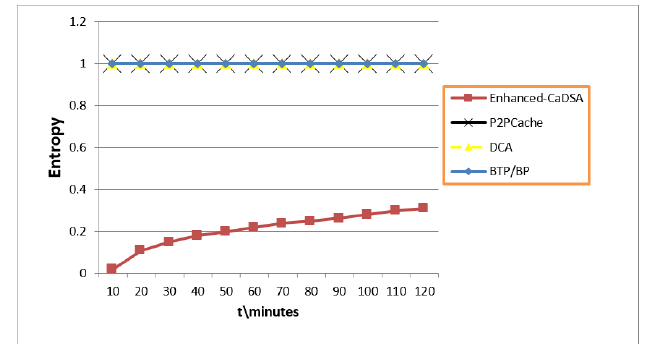
Figure 18. Privacy Factor (Entropy Metric).